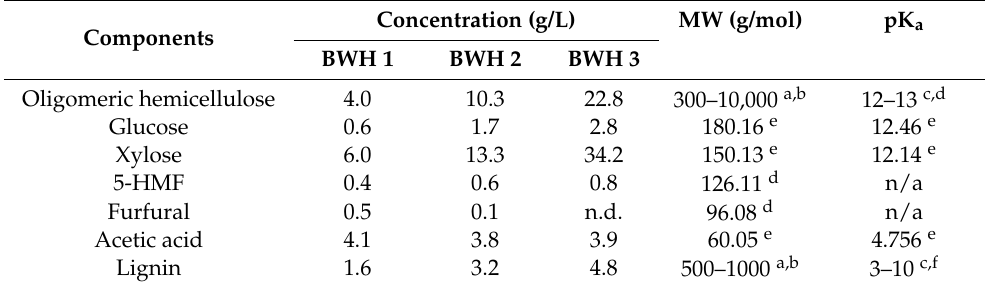
Table 1. Composition of beechwood hydrolyzate 1 (BWH 1), 2 (BWH 2), and 3 (BWH 3), and physicochemical properties of oligomeric hemicellulose, glucose, xylose, 5-hydroxymethylfurfural (5-HMF), furfural, acetic acid, and lignin (MW: molecular weight). Concentration (g/L) MW (g/mol) pK a Components BWH 1 BWH 2 BWH 3 Oligomeric hemicellulose